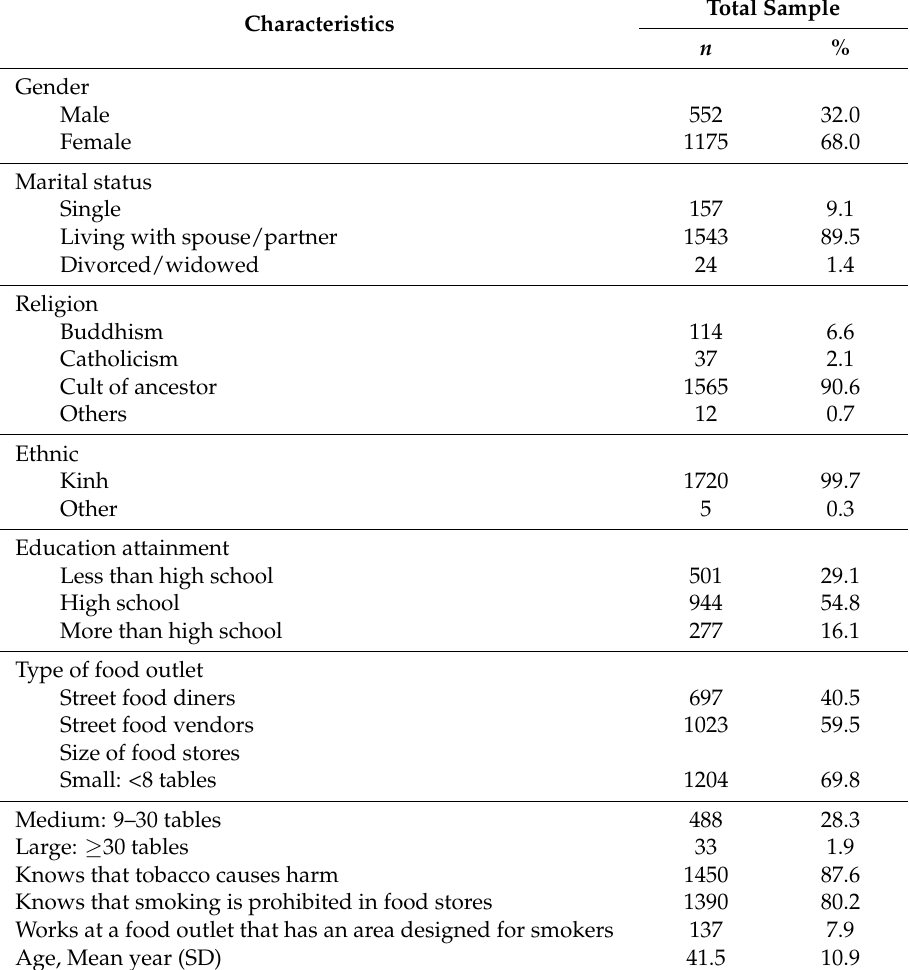
Table 1. Sample characteristics among street food service facilities, Hanoi, Vietnam ( n =